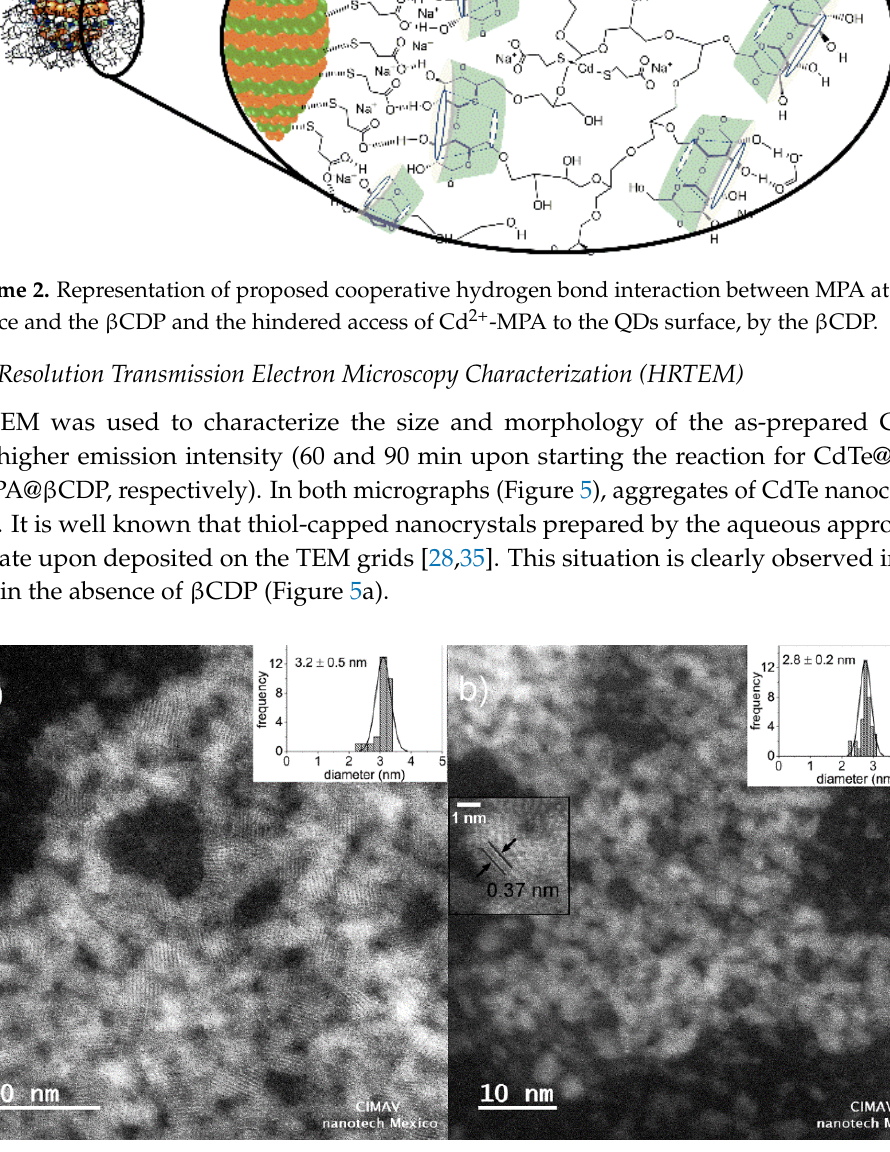
Transmission electron microscopy (TEM) micrograph of CdTe@MPA ( a )